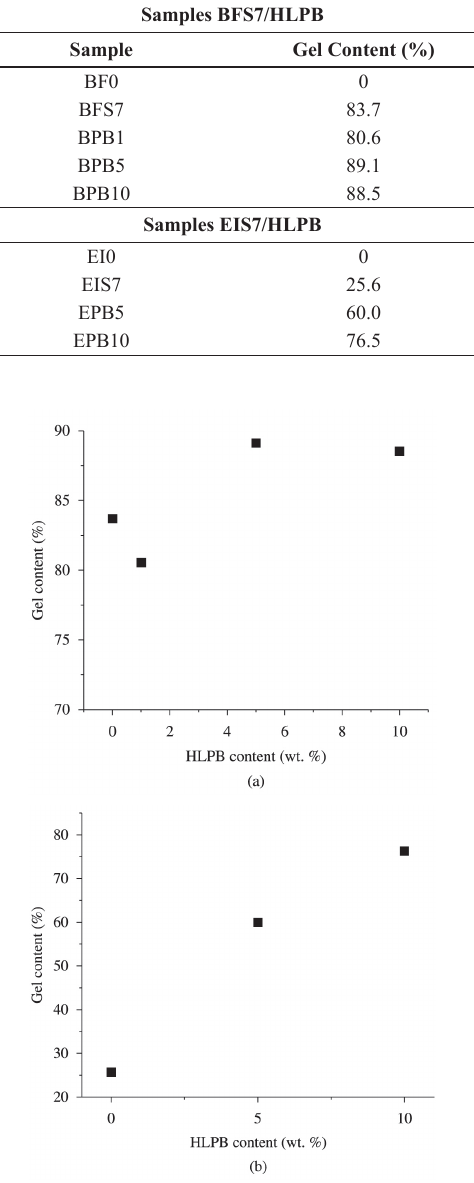
Figure 7. Stress-strain curves of the crosslinked